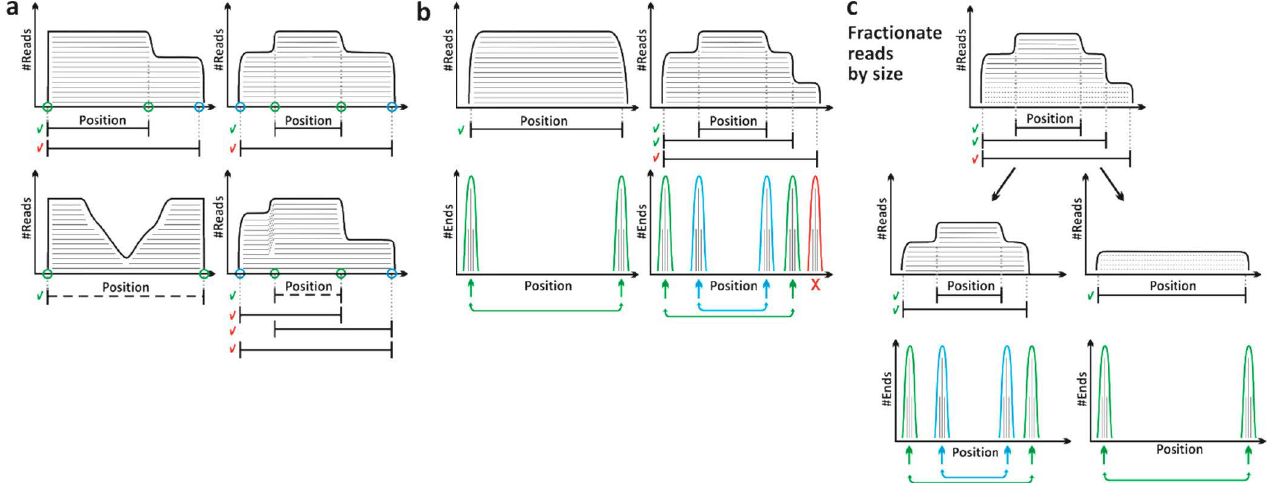
Figure 6. Comparison of biocomputational methods for processing product identification. ( a ) Scheme showing processing product identification by APART [40]. The processing products were identified by sites of consequence, sharp, and reversed coverage shift (green circles). Other sites of sharp coverage shift were discarded (blue circles). Some processing products were accepted (green checkmarks), and others were discarded (red checkmarks). #Reads = number of reads. ( b ) Scheme showing processing product identification by Flaimapper [38]. The processing products were identified by peak detection on 5 (cid:48) and 3 (cid:48) end densities, followed by reconstruction of fragments. Red cross = discarded peak. #Ends = number of ends. ( c ) Scheme showing detection of overlapping processing products by STARPA. Overlapping processing products (red checkmark) could be discarded. To avoid this, STARPA fractionates reads by size first, then employs Flaimapper to identify processing products from each